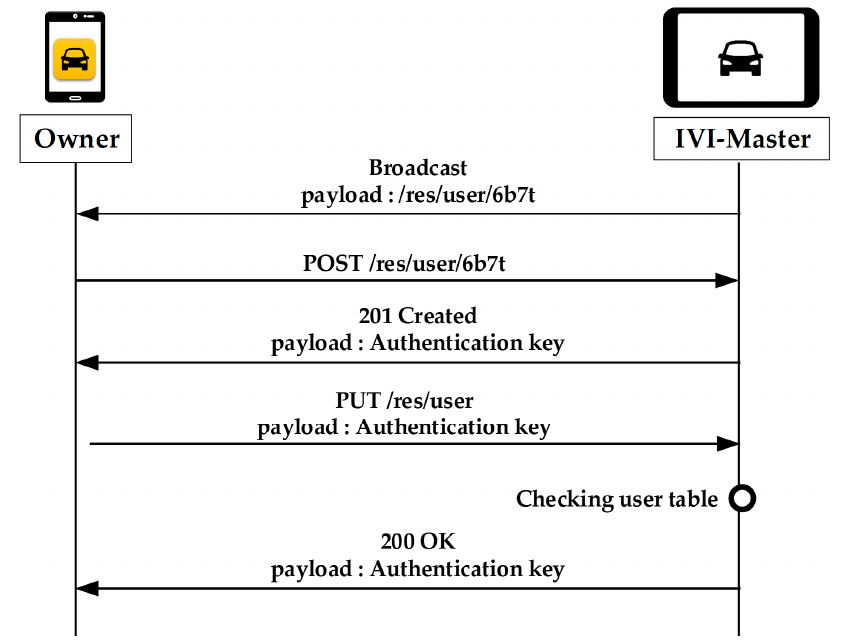
Figure 6. Registration of the owner.